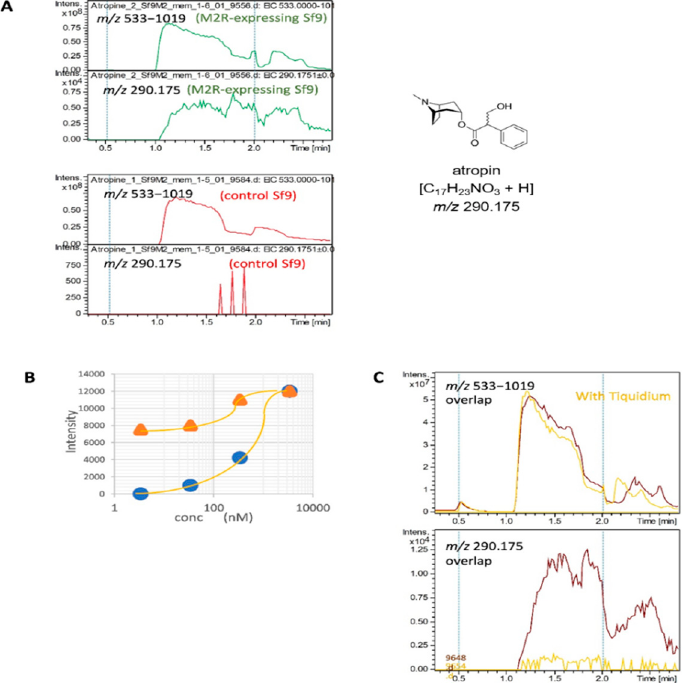
Figure 4. Detection of interaction between the membrane protein fractions from M2R-expression Sf9 cells and the M2R antagonist, atropine. ( A ) Comparison of Sf9 cells with high expression of M2R and the control Sf9 cells. In total, 340 nM of atropine was added to the membrane protein fraction from Sf9 cells, and the mixture was injected into SEC-MS. The elution profiles of atropine binding to its specific target protein were monitored using detection at m / z 290.175. LMW compounds binding non-specifically to membrane proteins were monitored using detection at m / z 533 − 1019. ( B ) In-teraction curve between atropine and the M2R-expressing Sf9-derived membrane proteins by SEC-MS. The membrane proteins were solubilized with (triangle) or without (circle) atropine and analyzed. ( C ) Effect of tiquizium on the atropine interaction. Atropine (3.4 µ M) was added to the membrane protein fraction, together with or without 240 µ M tiquidium; then, the interaction be-tween atropine and membrane proteins was